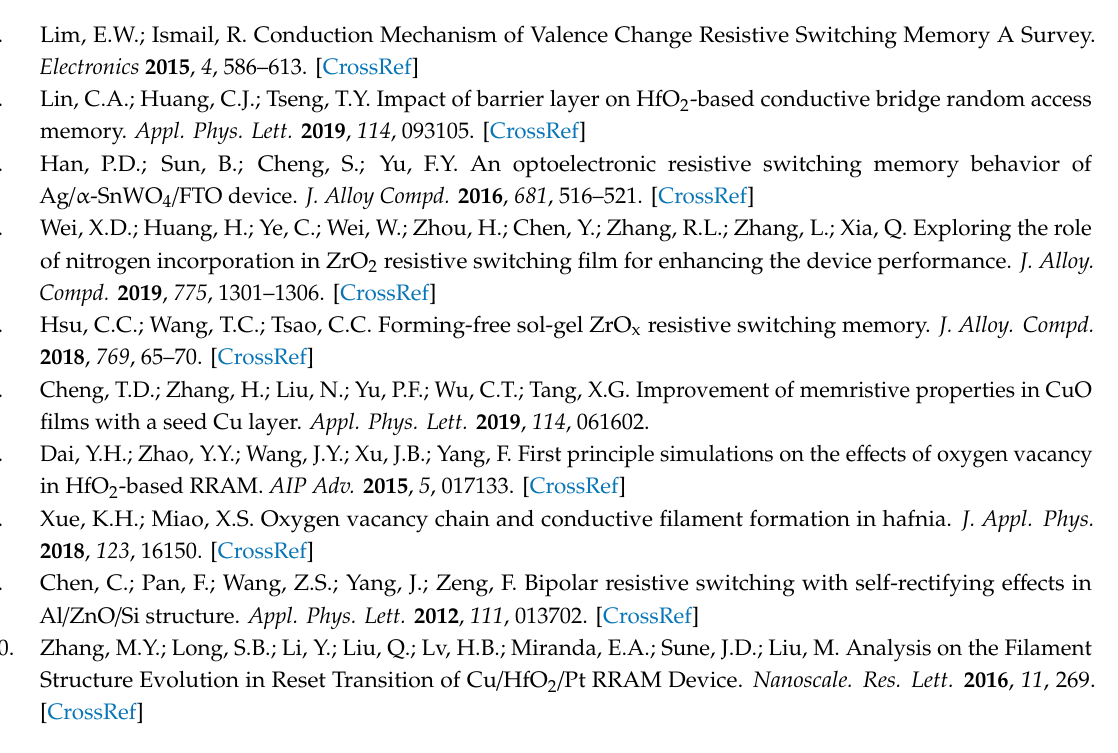
Figure S1: Current–Voltage plots of repeated samples, Figure S2: The FESEM pattern of the surface for S1 device, Figure S3: The FESEM pattern of the surface for S2